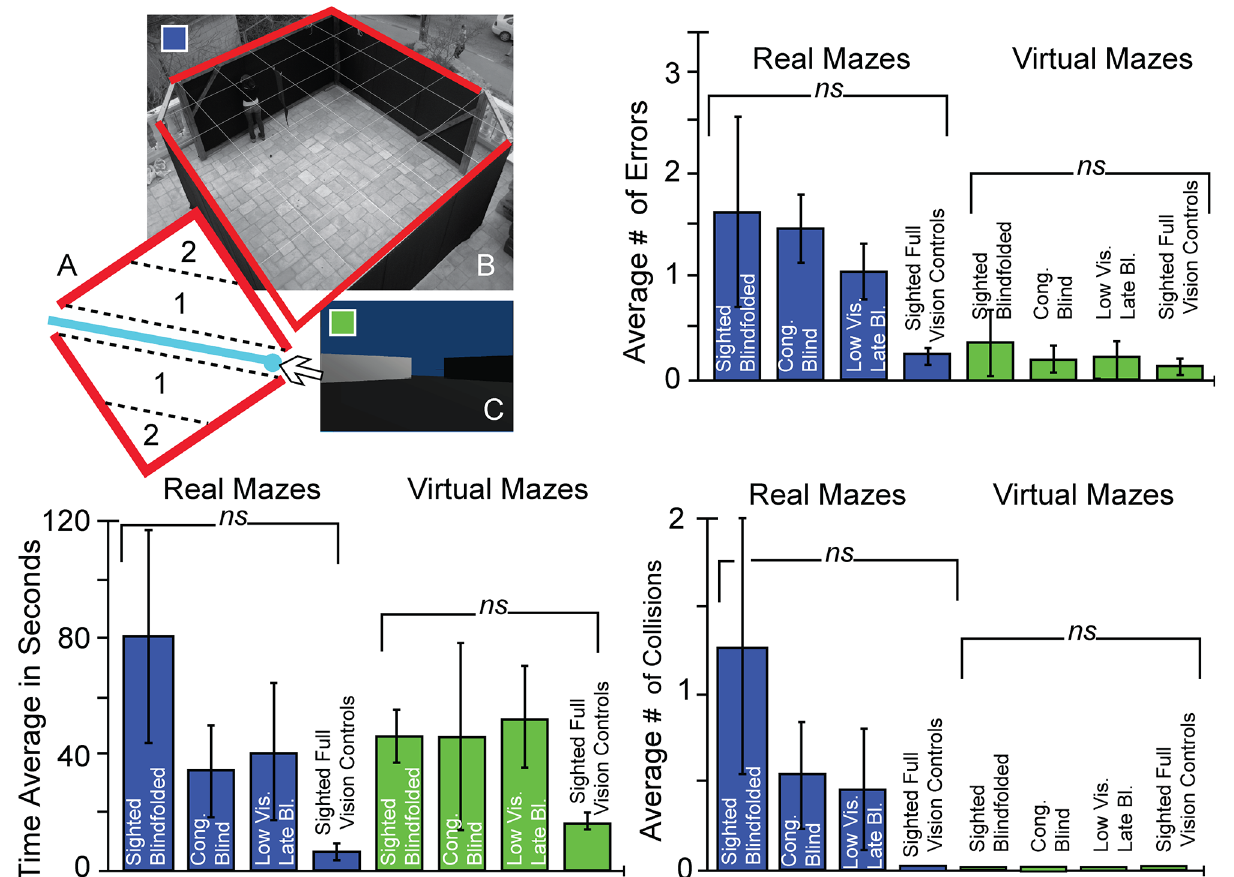
Fig 2. Experimental Setup 1 and Results. A. A diagram of the maze with the correct path in blue and the error zones delimited by the dotted lines. B. A top- down view of the real world maze. C. A first- person view of the virtual world maze. Bottom Left Panel: Time averages for all participants in the real world maze (blue) and the virtual maze (green). Top Right Panel: Error averages for all participants in the real world maze (blue) and the virtual maze (green). Bottom Right Panel: Collision averages for all participants in the real maze (blue) and the virtual maze (green). Asterisks indicate the level of significance. * p < 0.05; ** p < 0.01; *** p < 0.001.